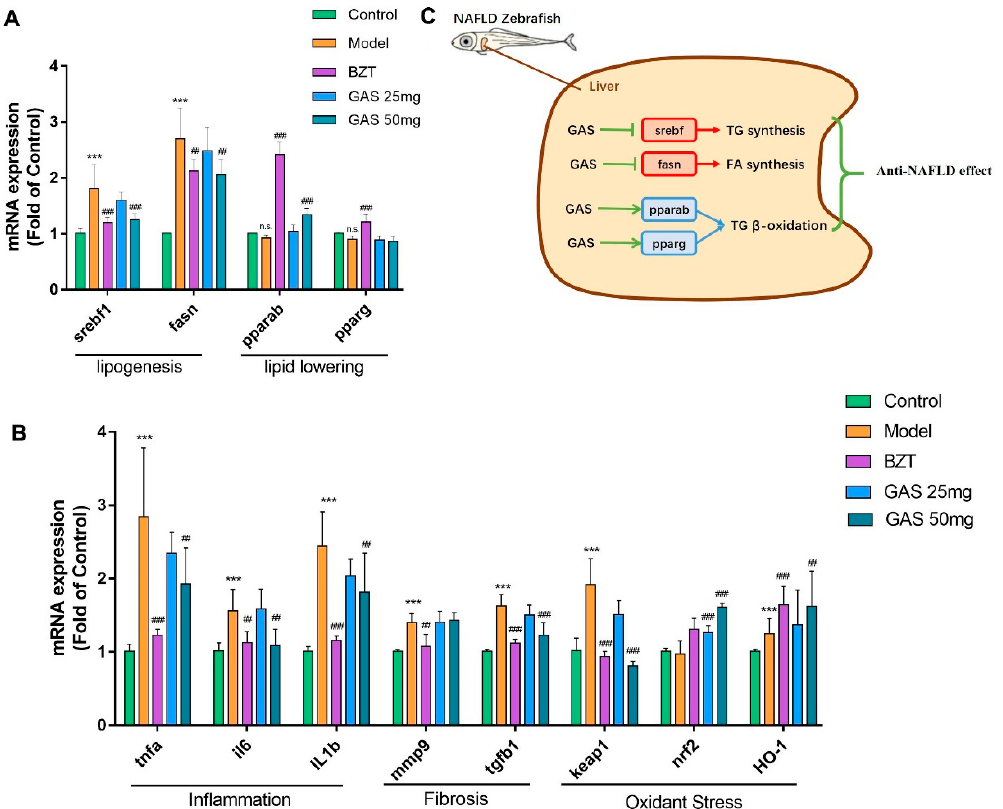
Figure 5. mRNA expression profile of GAS on HCD induced larval zebrafish and Molecular Mechanism of GAS. ( A ) mRNA expression of lipogenesis and lipid-lowering of larval zebrafish. ( B ) mRNA expression of inflammation, Fibrosis and oxidant stress of larval zebrafish. ( C )molecular mechanisms of lipid metabolism modulation by GAS. Bar indicate means ± SD. n.s. indicate no significant; *** p < 0.001 represent compared with the control. # p < 0.05, ### p < 0.001 represent compared with Model. p < 0.05 was considered as statistically significant, as calculated by One-way ANOVA followed by Tukey’s test. (n = 6).